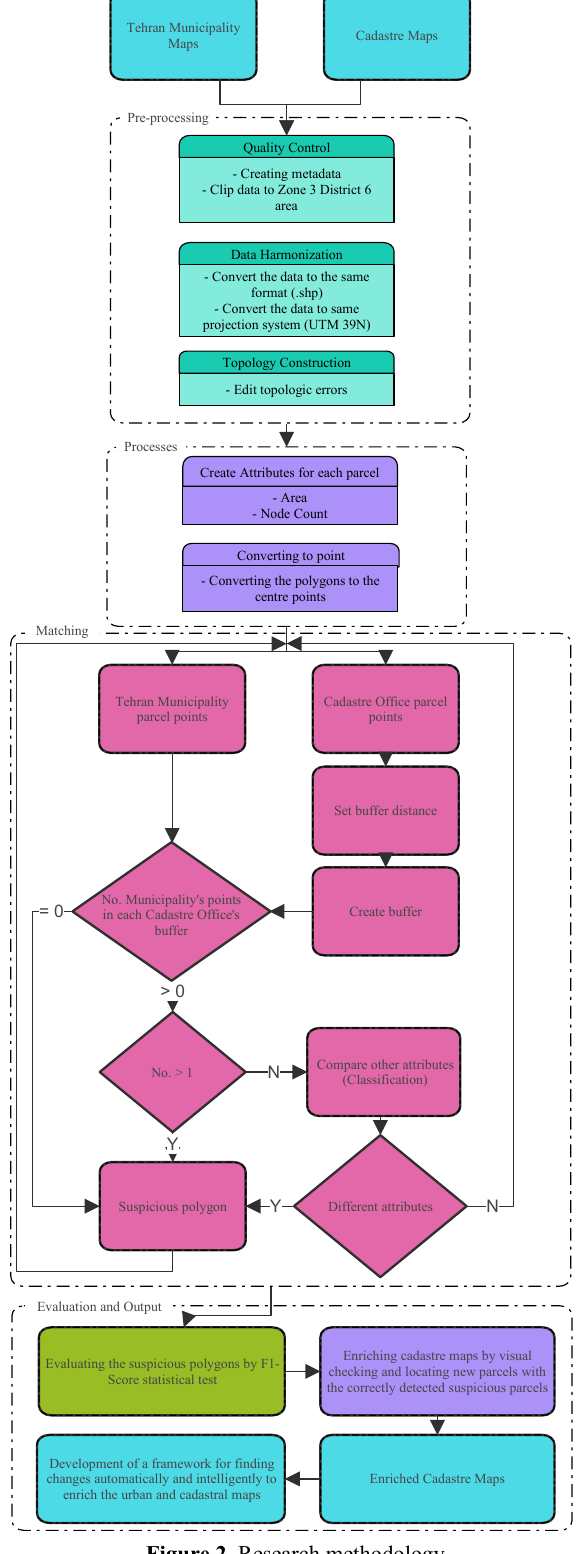
Figure 2. Research methodology.